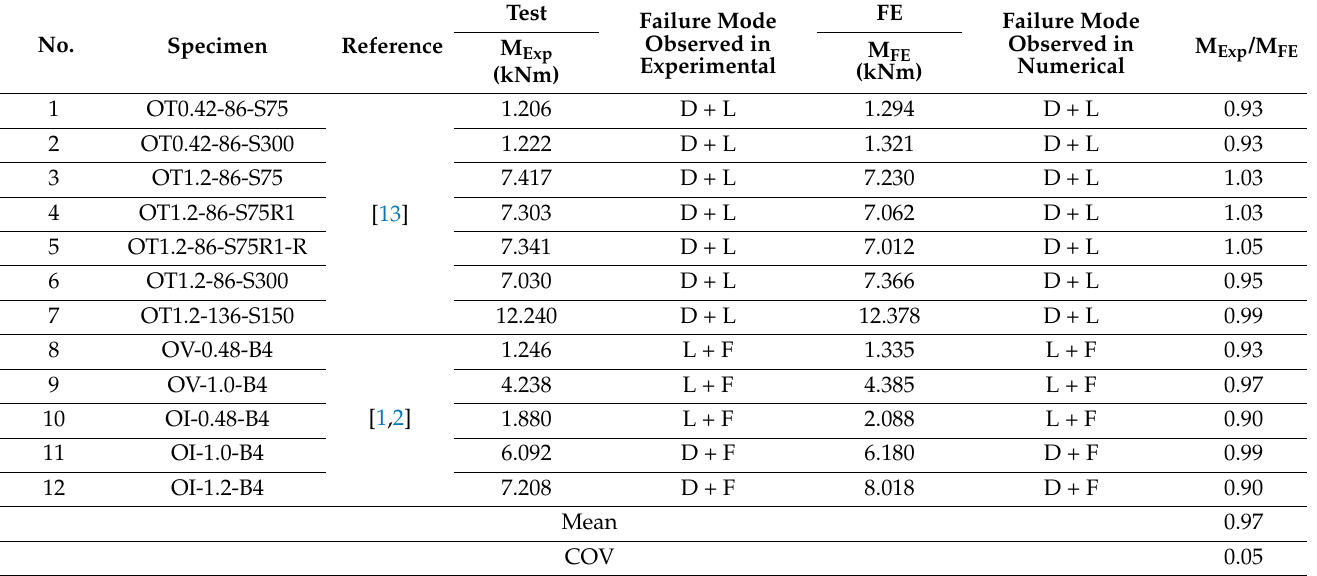
Table 3. Moment capacity comparison between experimental and numerical analyses.